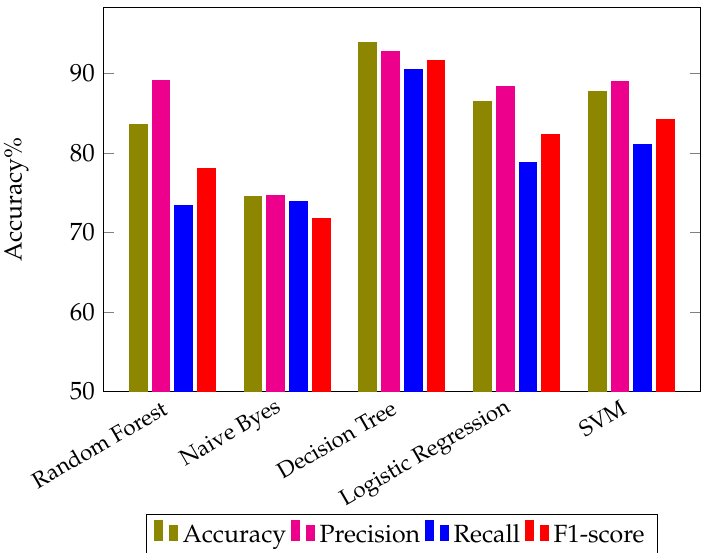
Figure 13. Machine learning Performance on Sinopharm